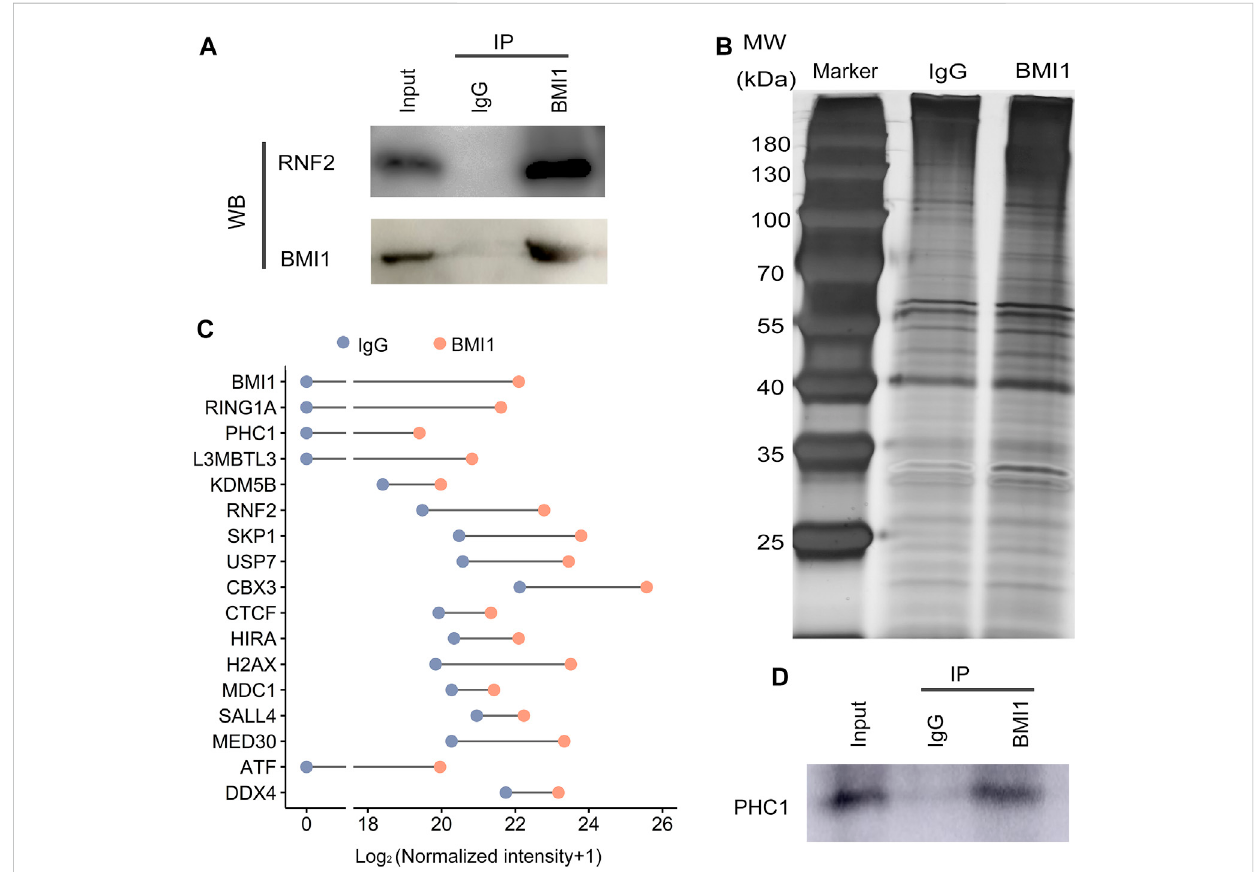
FIGURE 3 BMI1 interactomes. (A) Detection the interaction of BMI1 and RNF2 in undifferentiated spermatogonia by Co-IP. (B) Silver-stained SDS-PAGE gel fromIgGandBMI1puri fi cations. (C) BMI1-associatedproteinsareidenti fi edbymassspectrometry. (D) Con fi rmationoftheinteraction ofBMI1andPHC1.